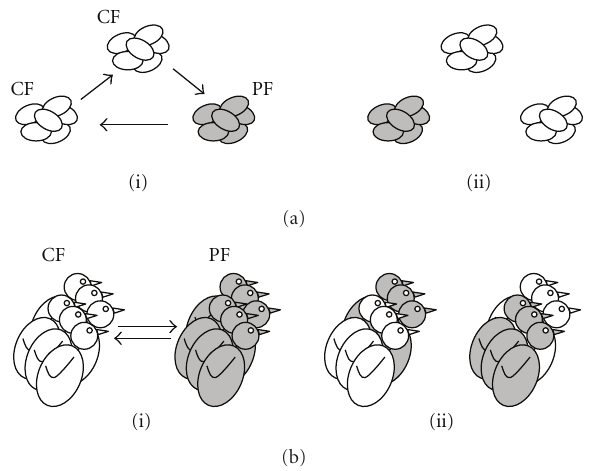
Figure 2: Cross-fostering of nestlings between collared (CF) and pied flycatchers (PF) on the Swedish island of ¨ Oland using two di ff erent approaches. (a) Complete clutches of eggs swapped between nests in three steps. (b) Partial cross-fostering of three day old nestlings between two nests. The left side (i) refers to the nests before swapping, and the right side (ii) refers to the same nests after swapping (collared flycatchers in white and pied flycatchers in grey).